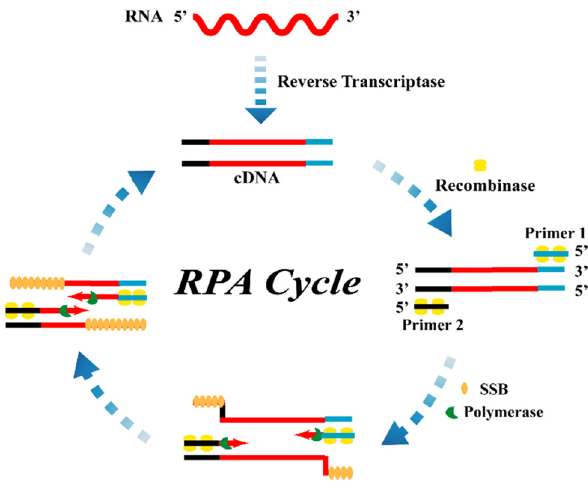
Figure 4: The schematic diagram of RT - RPA for RNA detection. Recombinase catalyzes the hybridization of primer with the homo - logous template sequence. The recombinase - primer fi laments scan the target dsDNA and promote strand exchange at cognate sites. The resulting structures are stabilized by ssDNA - binding proteins to prevent primer displacement by branch migration. DNA polymerase recognizes the primer 3 ′ ends left by recombinase disassembly and initiates the primer extension reaction. The binding/extension events of two opposing primers generate one complete copy of the amplicon together with the original